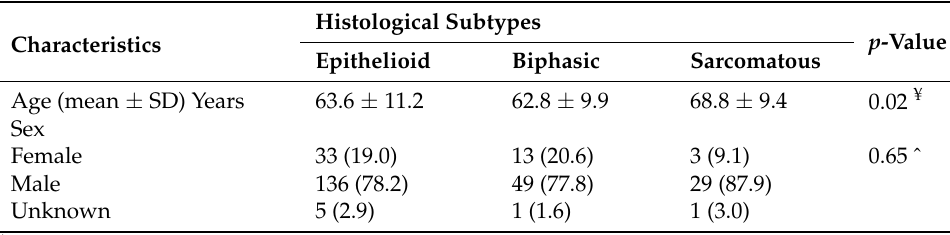
Table 5. Pattern of age and sex across the histological subtypes of mesotheliomas. Characteristics